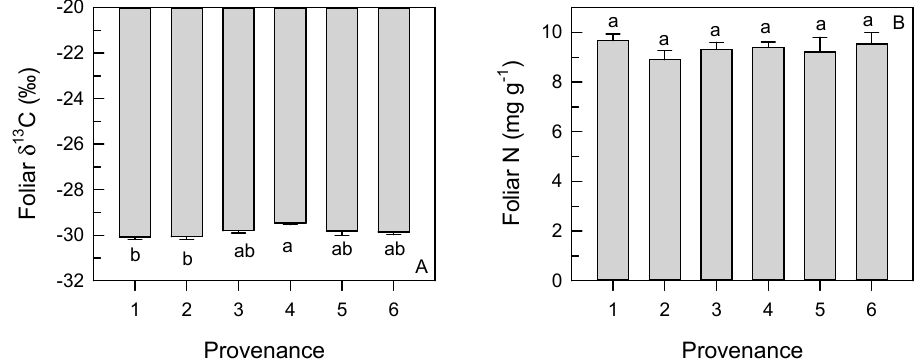
Figure 5. Mean (SE) foliar δ 13 C composition ( A ) and leaf nitrogen concentration ( B ) of longleaf pine trees from different provenances. Different letters indicate significant differences among provenances. Means reflect data pooled across two provenance test sites and 2 years (where applicable).